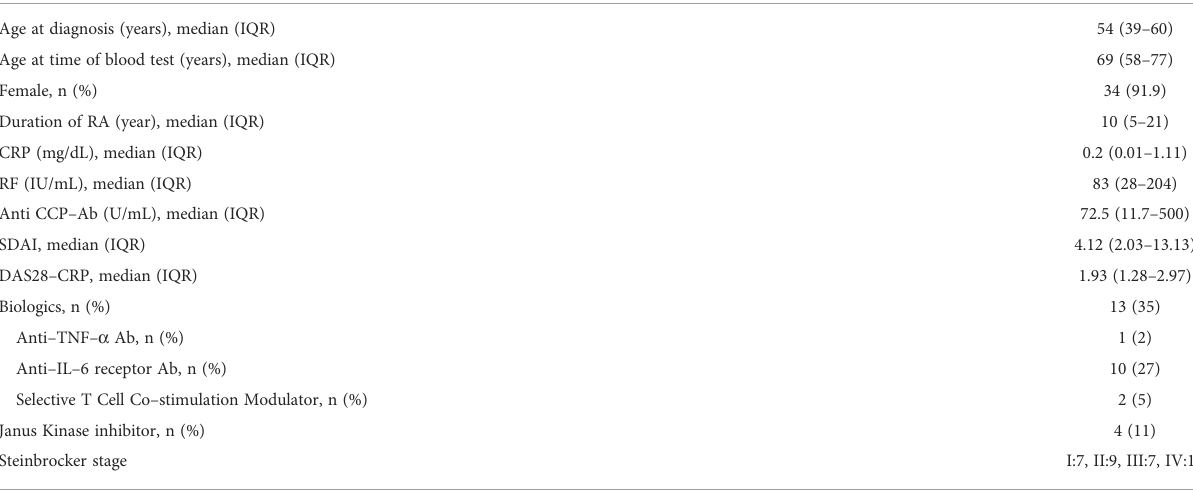
TABLE 1 Baseline characteristics of 37 Japanese patients with